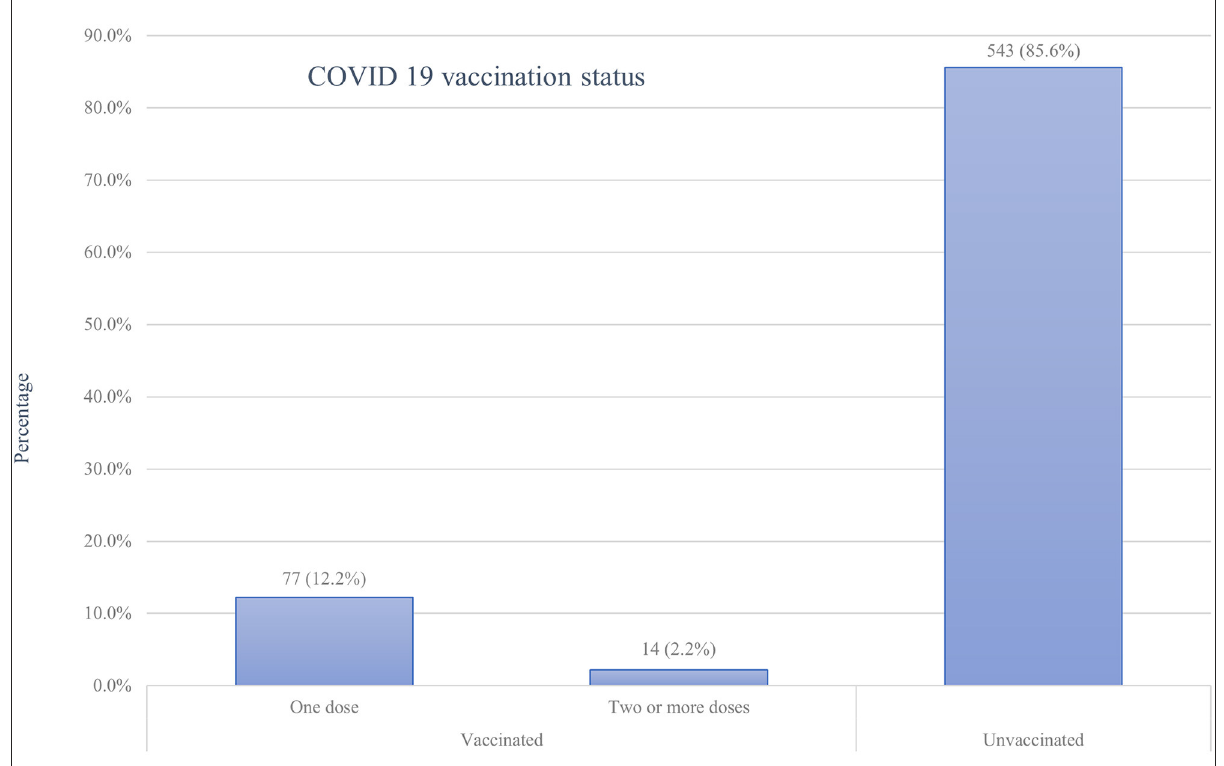
FIGURE2 COVID-19 vaccination status of pregnant women attending antenatal care in Debre Tabor public health institutions, Northwest Ethiopia, 2022.